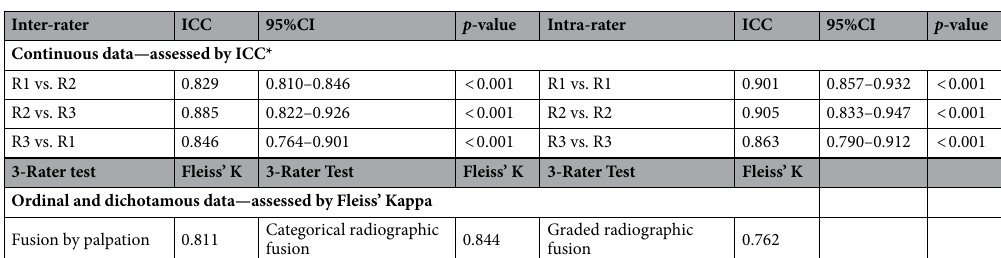
Table 3. Measurements of Rater Agreement for Post-operative Sample Assessments. * Interpreted as poor (< 0.5), moderate (0.5 to 0.75), good (0.75 to 0.9), and excellent (> 0.9). 122 . ** Interpreted as poor to fair (< 0.4), moderate (0.41 to 0.6), substantial (0.61 to 0.8) and almost perfect (0.81 to 1.0) 123